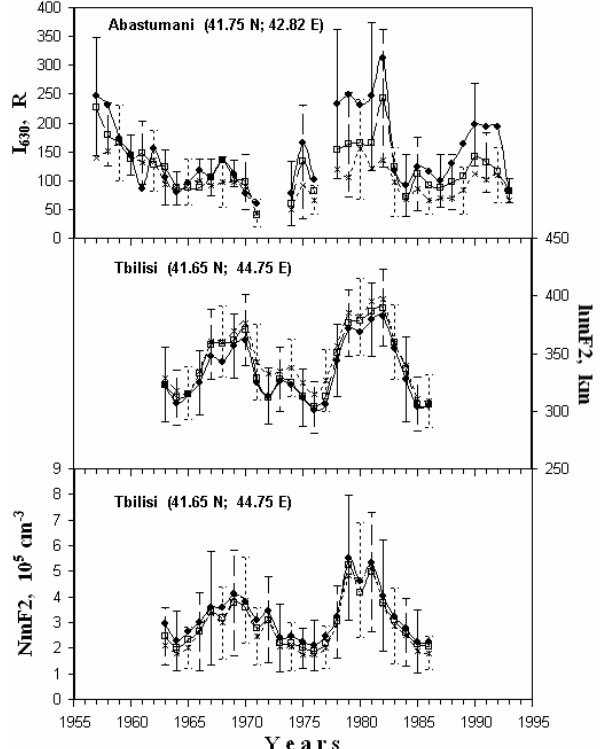
Fig. 2. Variation of the annual mean value of the red 630nm line total nightglow intensity I 630 , the ionosphere F2 layer peak height hm F2 and its electron density Nm F2 for three after midnight periods (00:00–01:00LT – full line and circles, 01:00–02:00LT – thin line and diamonds and 02:00–03:00LT – dashed line and “x”) observed at Abastumani in 1957–1993 and Tbilisi in 1963–1986. Vertical lines are one sigma error